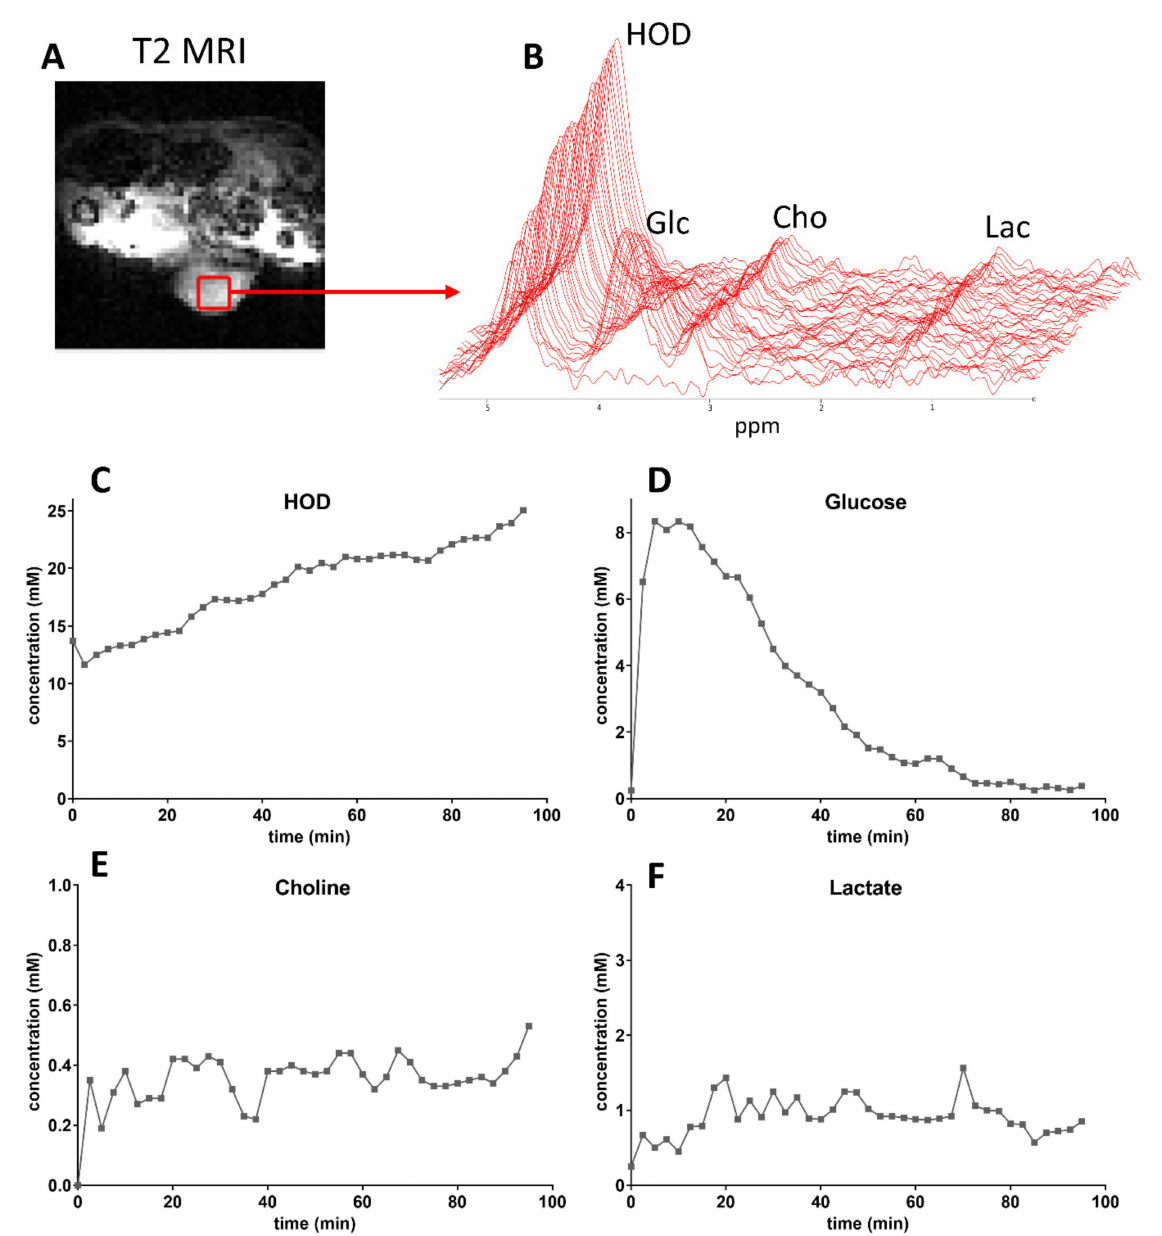
Figure 3. Low spatial resolution 3D DMI (50 µ L voxels), recorded at a time resolution of 2:24 min, from an SKRC 17T-CA9- Luc tumor growing in the flank of a mouse. ( A ). T2 weighted MRI with a selected voxel inside the tumor indicated by a red box. ( B ). Time series of 2 H MR spectra consecutively recorded from this voxel over a period of 90 min showing an increasing HOD signal, an increasing and decreasing glucose signal ( C , D ), a rapidly increasing and then constant choline signal and a signal for lactate appearing during the decline of the glucose signal. ( E , F ). Time curves of metabolite tissue concentrations